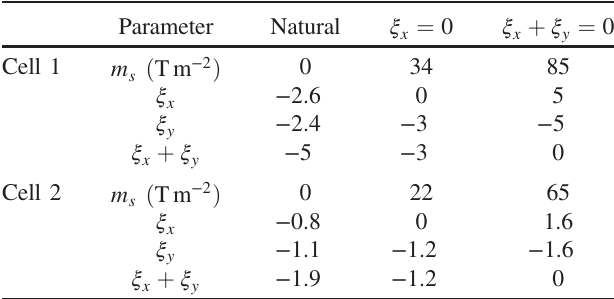
TABLE II. Cell chromaticities vs sextupole strength for the undulator cell (Cell 1) and for the cell in the arcs without insertions (Cell 2).